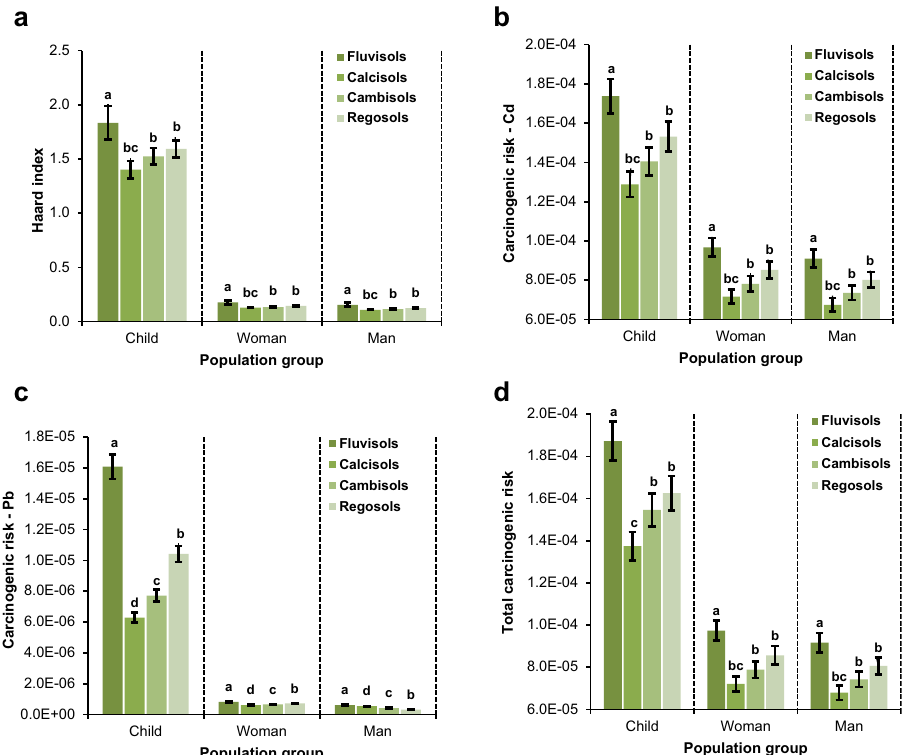
Figure 7. The effect of soil type on the mean hazard index ( a ) and carcinogenic risk of Cd ( b ), Pb ( c ), and Cd + Pb in urban soils. Different letters indicate significant differences in carcinogenic risk within population groups at P < 0.05 confidence